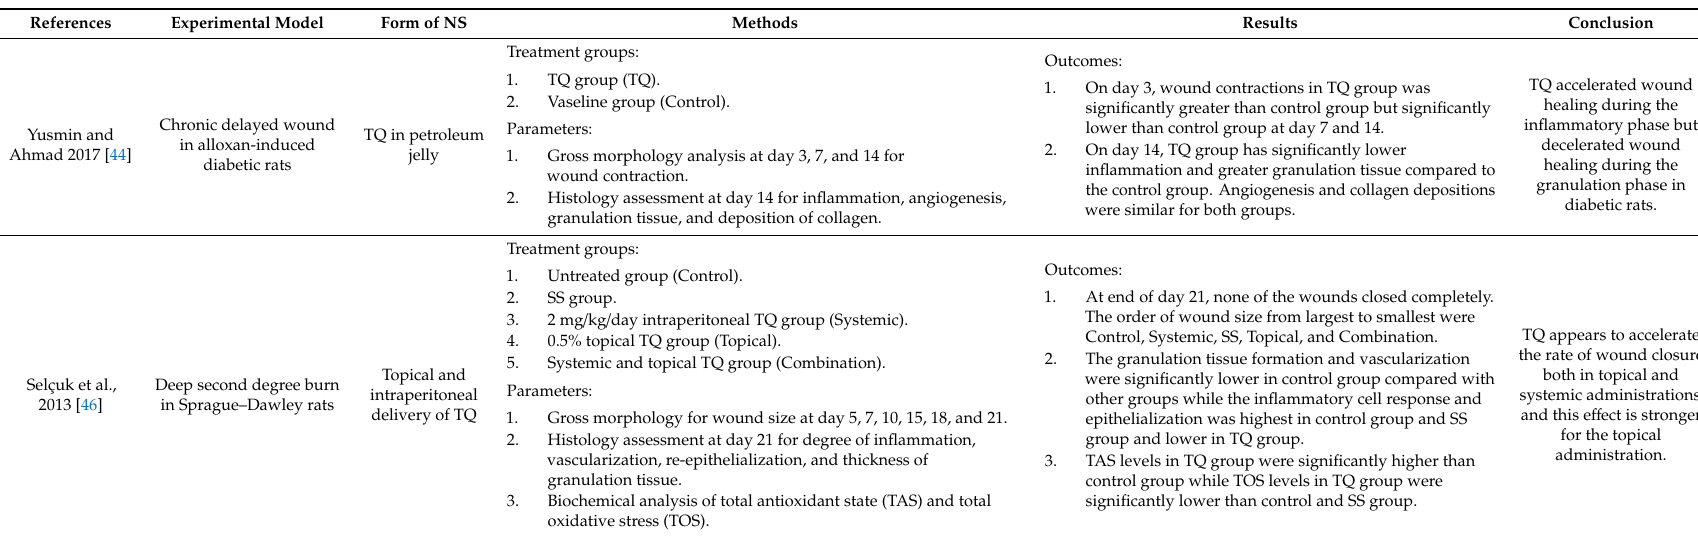
Table 2. Summary of thymoquinone (TQ)